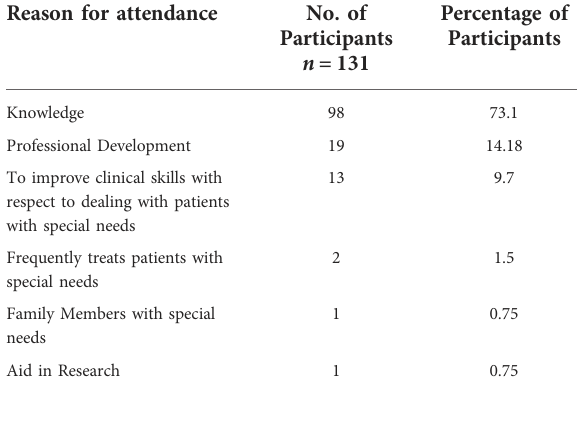
TABLE 1 Demographics of participants in the two surveys.